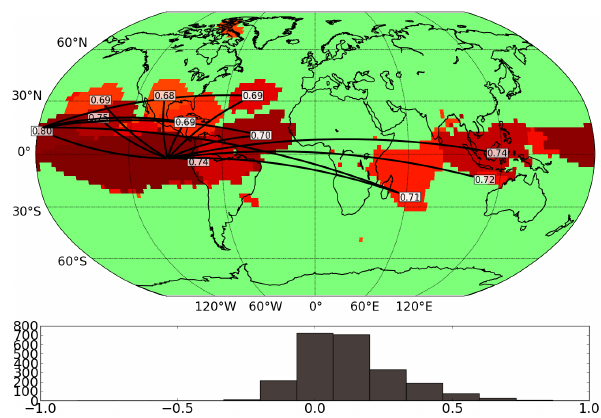
Fig. 7. Pairs of regions that show high relevance for the global graph evolution. Top panel: for fifteen region pairs with strongest correla- tion of inter-regional connectivity evolution with the global 2562- node network threshold evolution, a link is shown and the regions highlighted (darker red corresponds to the highest correlation the region is involved in, also given by the number written within the region).